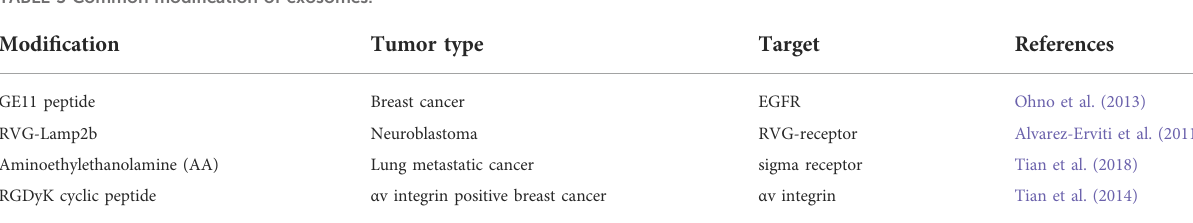
TABLE 3 Common modi fi cation of